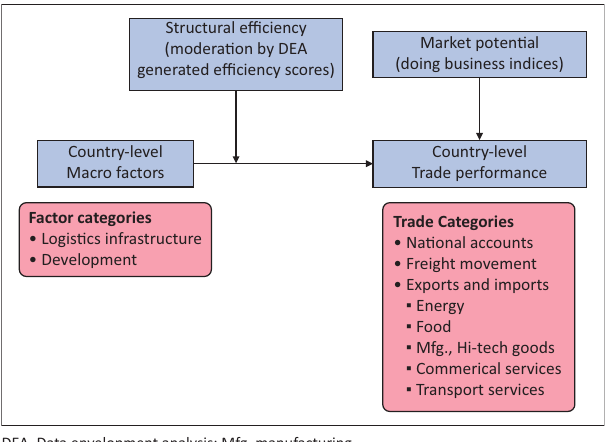
FIGURE 1: Conceptual model – The roles of logistics, efficiency and market potential in determining trade performance.